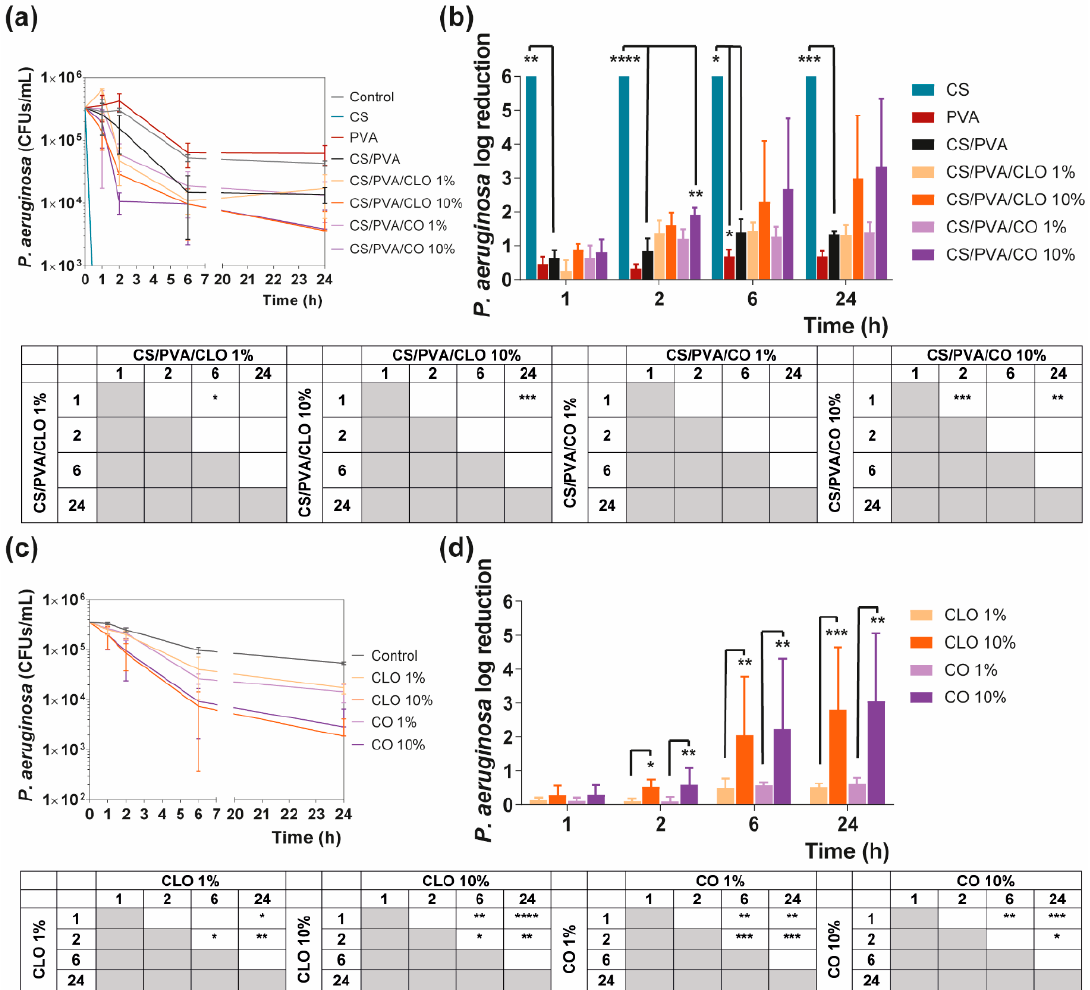
Figure 10. Time–kill curves of ( a ) unloaded and EO-loaded films and ( c ) EOs at film loaded concentration, against P. aeruginosa bacteria, up to 24 h of culture. Positive controls for P. aeruginosa (growth without agent or film) were also conducted (grey line), reaching a maximum value of ≈ 4.3 × 10 6 CFUs/mL, after a 24 h culture (data not shown in graphic). P. aeruginosa reduction (calculated as log reduction) of ( b ) the films and ( d ) EOs in relation to control samples. The elimination of 100% of bacteria was considered as log 6. Results are represented as the mean ± SD ( n = 3). Statistically significant differences can be highlighted, * p < 0.05, ** p < 0.005, *** p < 0.001, and **** p < 0.0001, for each sample at each time point in comparison to ( c ) each free EO or to the ( d ) loaded CS/PVA films, using the Kruskal-Wallis test, followed by the Dunn’s multiple comparisons test. The evolution over time of each EO and EO-loaded film’s AM action was also examined and shown in a table format for